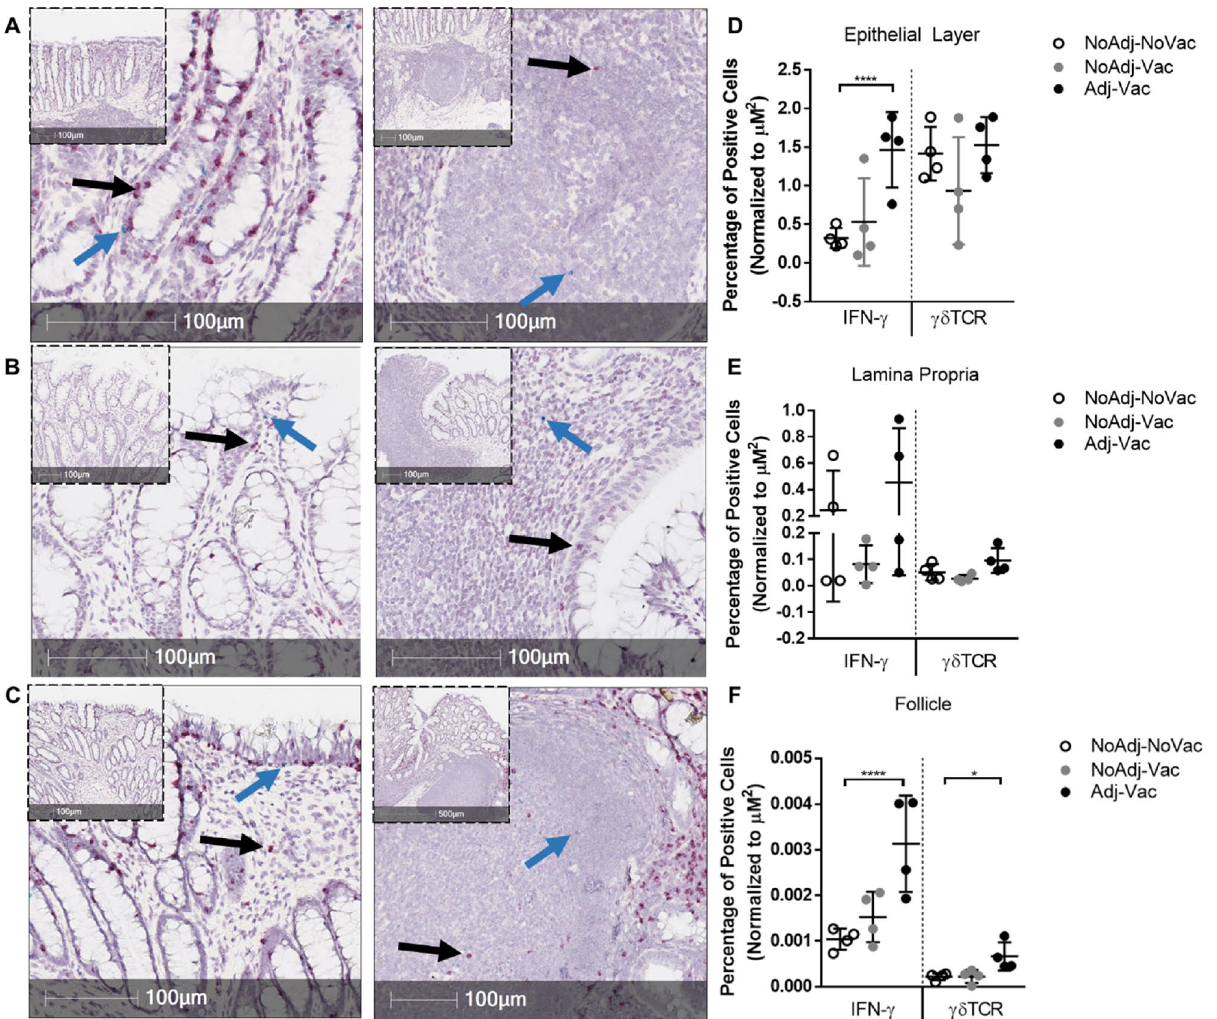
Figure 2. RNA in situ hybridization of IFNG and TRDC transcripts. Follicular recto-anal junction (RAJ) isolated from a representative animal which received no adjuvant or vaccine strain (NoAdj-NoVac) ( A ) depicting mucosal epithelium (left panel) and submucosa-follicle (right panel). Follicular RAJ isolated from a representative animal which received non-adjuvanted-Δ hha - E. coli vaccine (NoAdj-Vac) ( B ) depicting mucosal epithelium (left panel) and submucosa-follicle (right panel). Follicular RAJ isolated from a representative animal which received adjuvanted-Δ hha - E. coli vaccine (Adj-Vac) ( C ) depicting mucosal epithelium (left panel) and submucosa-follicle (right panel). Graphical representation of γδTCR + (right) and IFNγ + (left) from mucosal epithelium ( D ), submucosa lumen ( E ) and submucosa-follicle ( F ). On inset panels indicated in ( A – C ), an approximate 5 × magnification section is represented whereas larger panels are approximately 20 × magnification of the inset. Black arrows indicate γδ T cell staining (specifically, the T-cell receptor, delta chain RNA) and blue arrows indicate IFNγ (interferon RNA) staining. Open circles indicate NoAdj-NoVac, grey circles represent NoAdj-Vac, and black circles represent Adj-Vac group. Each symbol represents an individual animal. N = 4 per group. Bars = ± SD. Bar data represents percentage of cells measured by RNA staining. One- way ANOVA with Tukey’s post-test was utilized for statistical analysis. **** p < 0.001, * p <